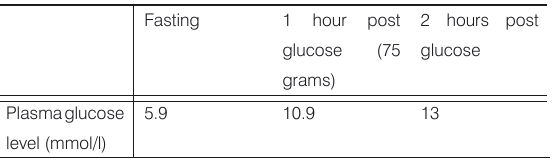
Table 1. OGTT of patient presented in the study.